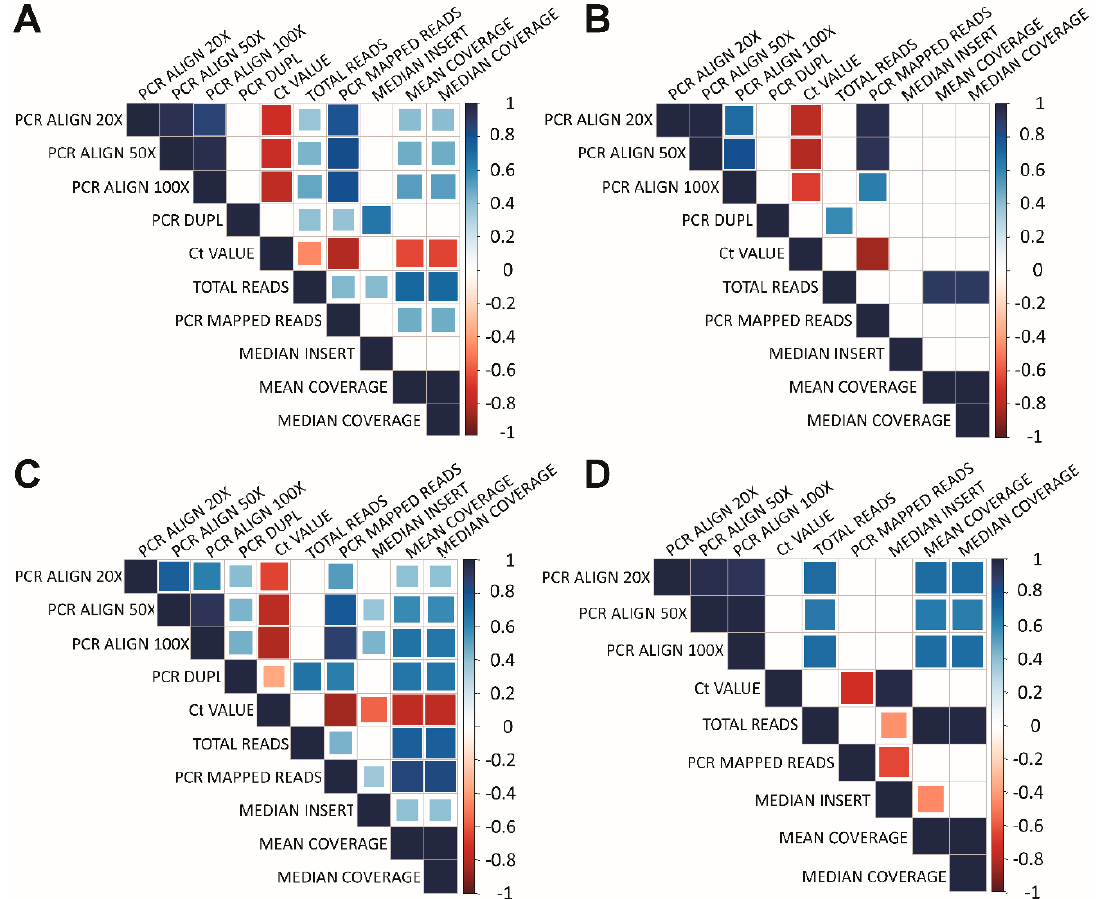
Figure 2. Mutual correlation of selected categories of metrics related to ( A ), NEB+TWIST1 (plex 1–3); ( B ), NEB+TWIST2 (plex 2–3); ( C ), ILLUMINA (plex 1–8); and ( D ) PARAGON (no plex) approach. We can observe a significant negative correlation between Ct value and % of mapped reads to the reference genome. Lower Ct number caused higher number of % mapped reads and therefore results in better coverage. PRC ALIGN 20 × , the percentage of bases that were aligned to the reference sequence at least 20 × ; PRC ALIGN 50 × , the percentage of bases that were aligned to the reference sequence at least 50 × ; PRC ALIGN 100 × , the percentage of bases that were aligned to the reference sequence at least 100 × ; PRC DUPL, percentage of duplicate sequences (not generated in the case of PARAGON approach); Ct VALUE, reflecting the viral load; TOTAL READS, total number of reads which were yielded by sequencing on MiSeq (Illumina); PCR MAPPED READS, total number of reads which were mapped to target regions; PERC_MAPPED, percentage of mapped reads which were mapped to target regions; MEDIAN INSERT, median value of insert length; MEDIAN COVERAGE, median coverage of reads which were mapped to target regions; MEAN COVERAGE, mean coverage of reads which were mapped to target regions.